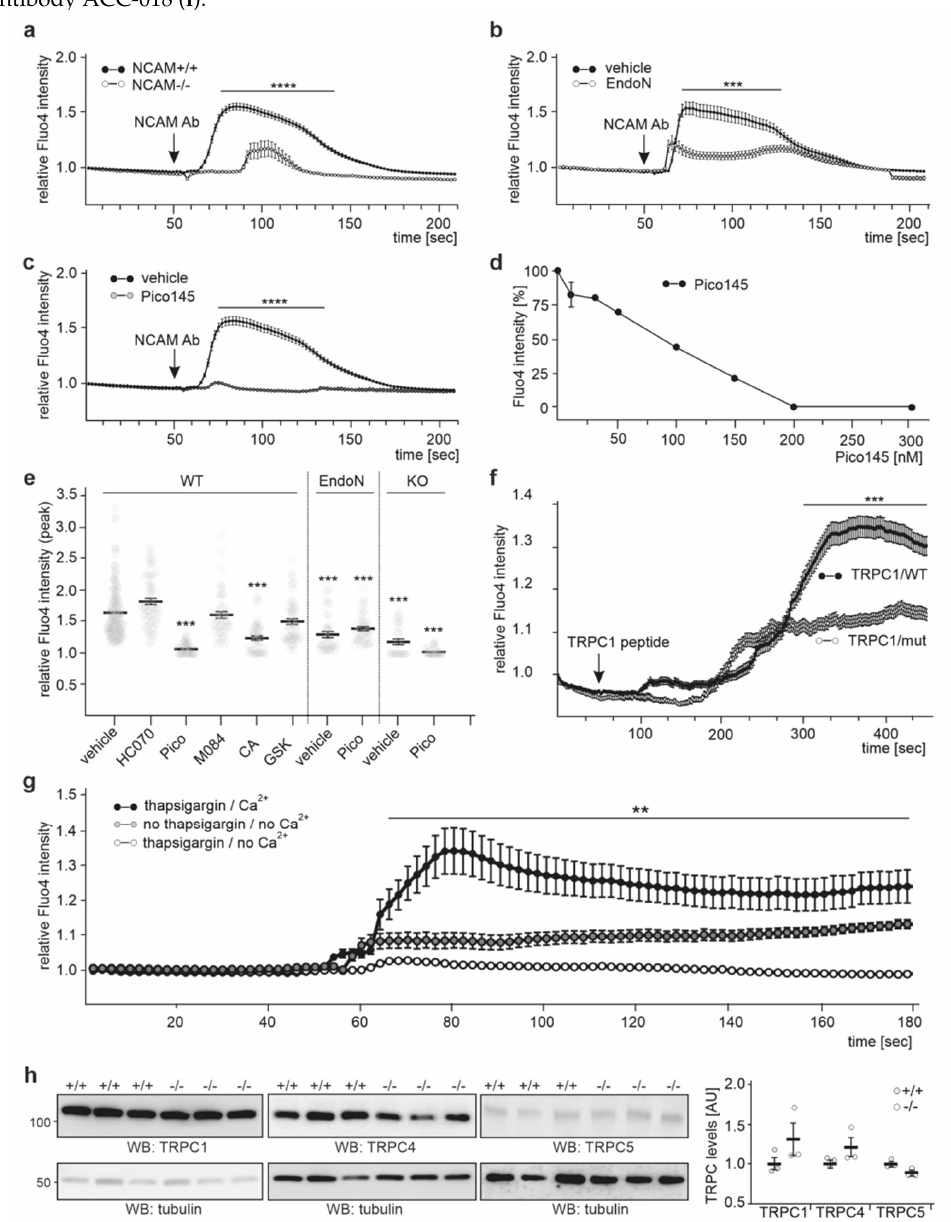
Figure 9. NCAM regulates the Ca 2+ entry in cortical neurons via TRPC1, − 4, and − 5. Cortical neurons from wild-type (NCAM+/+) and NCAM-deficient (NCAM − / − ) mice were treated without or with the PSA-degrading enzyme EndoN, loaded with Fluo-4 AM, preincubated with colominic acid/PSA (CA) or the TRPC inhibitors Pico145, HC-070, M084, or GSK-417651A, treated with or without function-triggering NCAM antibody, and subjected to Ca 2+ imaging. Mean values ± SEM from 3 independent experiments analyzing 10 cells per treatment and experiment are shown for Ca 2+ responses after treatment with function-triggering NCAM antibody (arrow; NCAM Ab) of wild-type and NCAM-deficient neurons ( a ), of non-treated and EndoN-treated wild-type neurons ( b ), and of wild-type neurons treated with or without Pico145 ( c ). ( d ) Pico145 reduces the NCAM-stimulated Ca 2+ response in a concentration-dependent manner. Mean values ± SEM from 3 experiments analyzing 10 cells per experiment are shown. ( e ) Scatter plots show the peak Fluo-4 AM intensity values for wild-type neurons (WT), NCAM-deficient (KO) neurons, and En- doN-pretreated wild-type neurons (EndoN) after NCAM antibody treatment in the absence (vehi- cle) or presence of Pico145 (Pico), HC-070 (HC070), M084, GSK-417651A (GSK), or colominic ac- id/PSA (CA). Mean values ± SEM and single values from 3 experiments analyzing 10 cells per treatment and experiment are shown (** p < 0.01, *** p < 0.001, **** p < 0.0001 relative to values from vehicle-treated wild-type neurons; one-way ANOVA with Kruskal–Wallis post hoc test). ( f ) Rep- resentative time courses are shown for the Ca 2+ responses after application of wild-type neurons with cell-penetrating unmutated tat-TRPC1/WT and mutated tat-TRPC1/mut peptides (arrow;